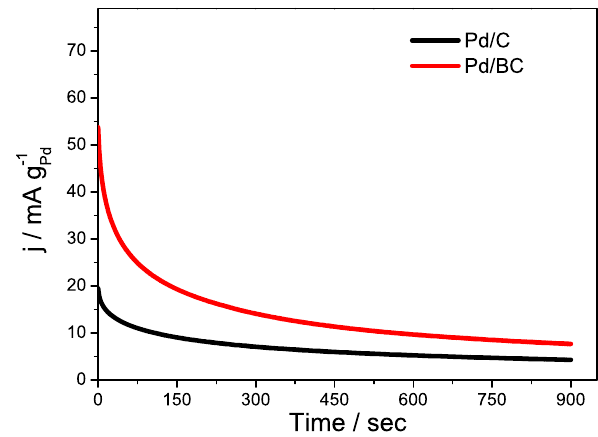
Fig. 7 Chronoamperometric results at − 0.35 V of Pd/C and Pd/BC in 1 moL L −1 KOH + 1 moL L −1